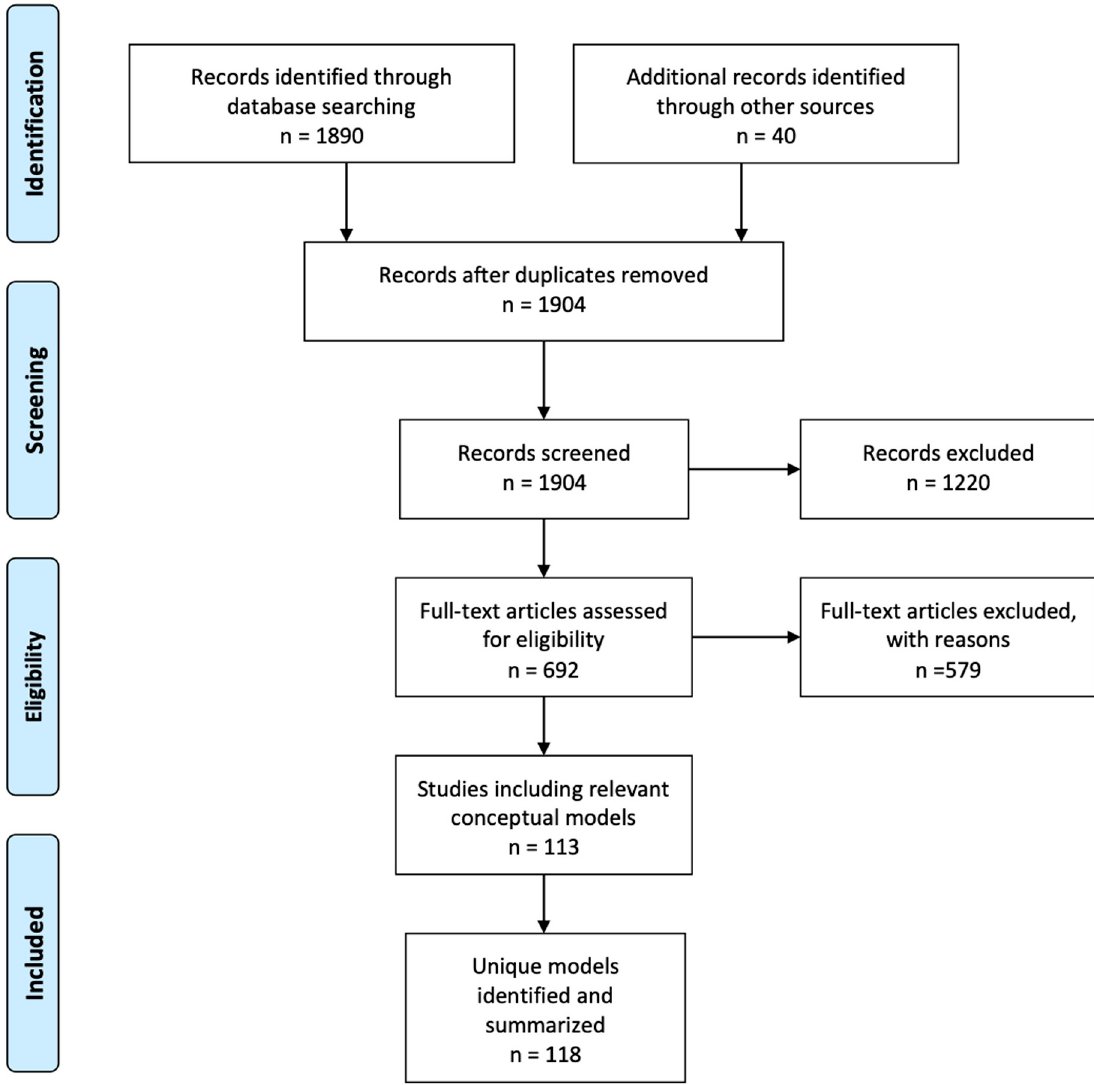
Fig 2. Flow diagram of included